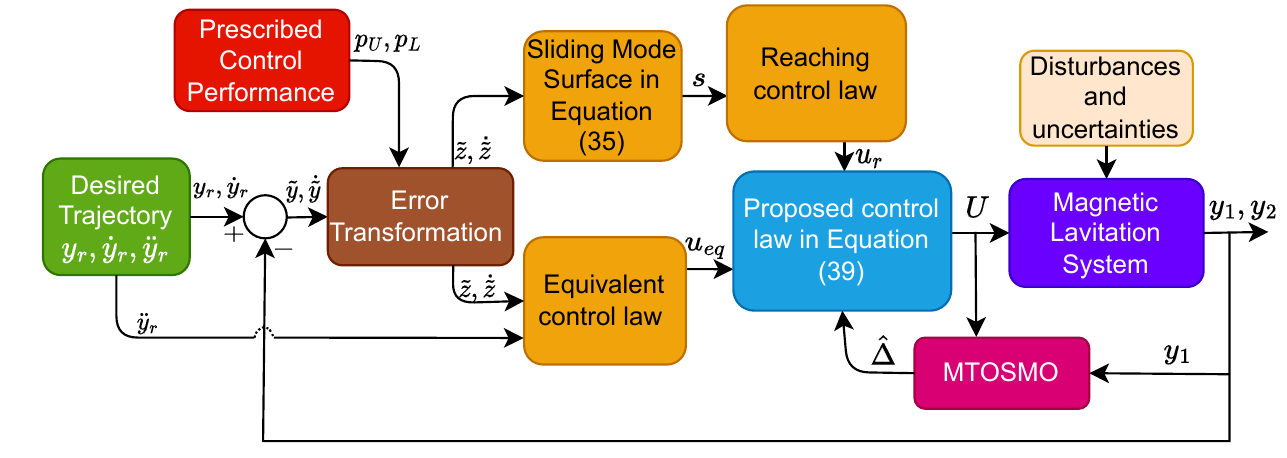
Figure 3. The block diagram of the proposed control